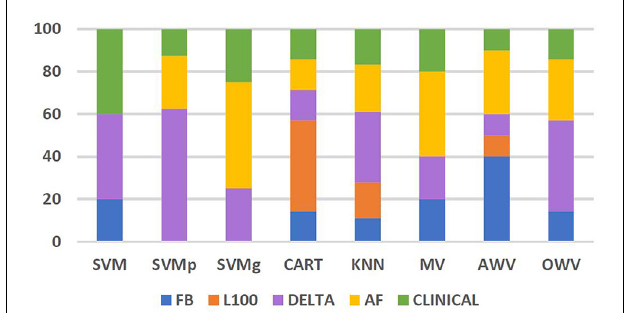
FIGURE 7 | Percentage of features from each feature group used by the different classification methods. AF, atrial fibrillation; AWV, accuracy weighted voting; CART, classification and regression trees; FB, flashback; KNN: K-nearest neighbors; L100, last 100 beats; OWV, optimum weighted voting; SVM, support vector machine; SVMg, support vector machine Gaussian kernel; SVMp, support vector machine polynomial